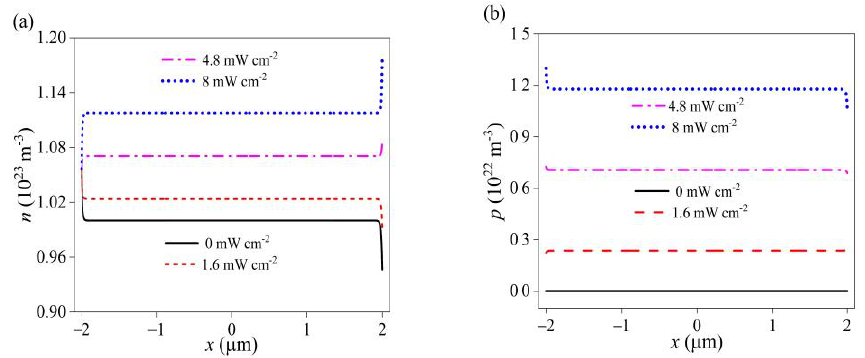
Figure 3. The carrier concentration distribution of ( a ) electron and ( b ) hole with different ultraviolet intensities under a compressive stress of − 5 MPa.